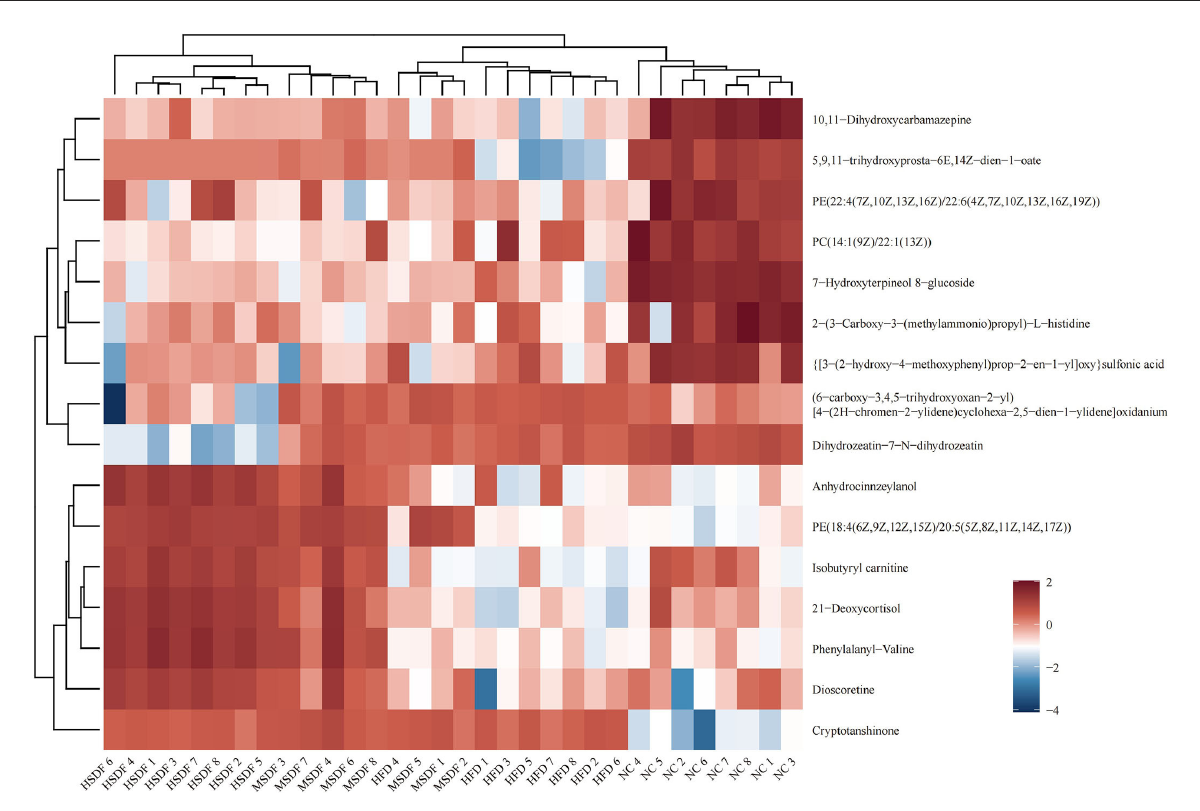
FIGURE5 Heat map of metabolite clustering analysis of colonic contents ( n = 8). Red indicates up-regulation and blue down-regulation. Columns and rows represent colonic content samples and metabolites,